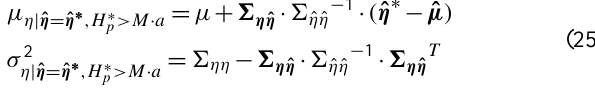
The value of a is again identified as the one that mini- mizes the predictive variance of the upper sample. Finally, in the third phase the series of expected values computed in the second phase is processed using the TNDs as described in Sect.